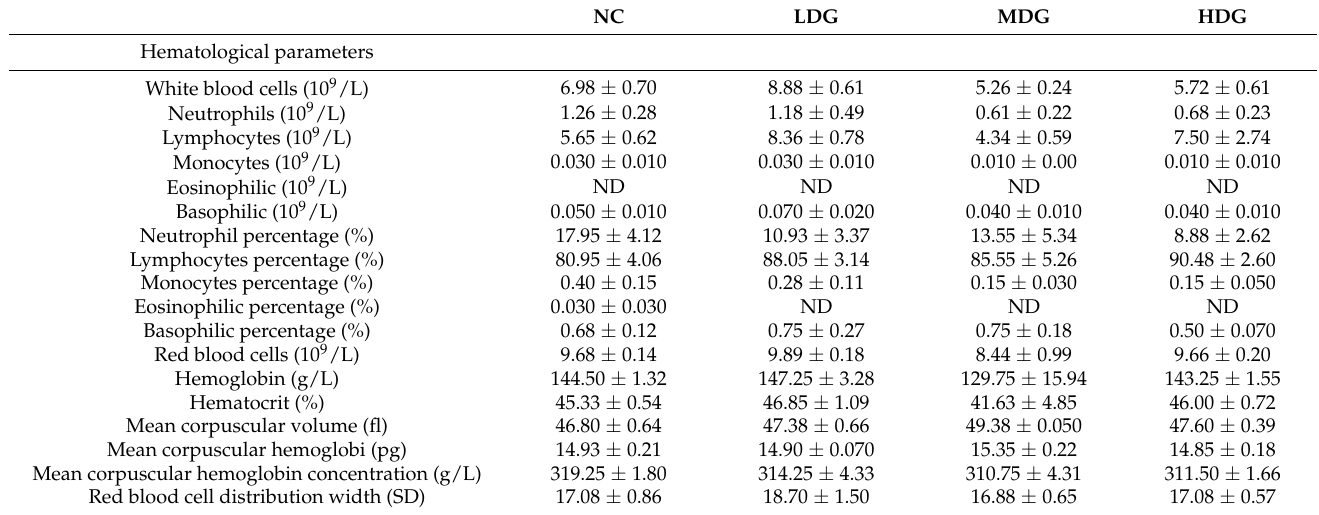
Table 4. Hematological parameters and serum biochemistry in mice for 28-day repeated